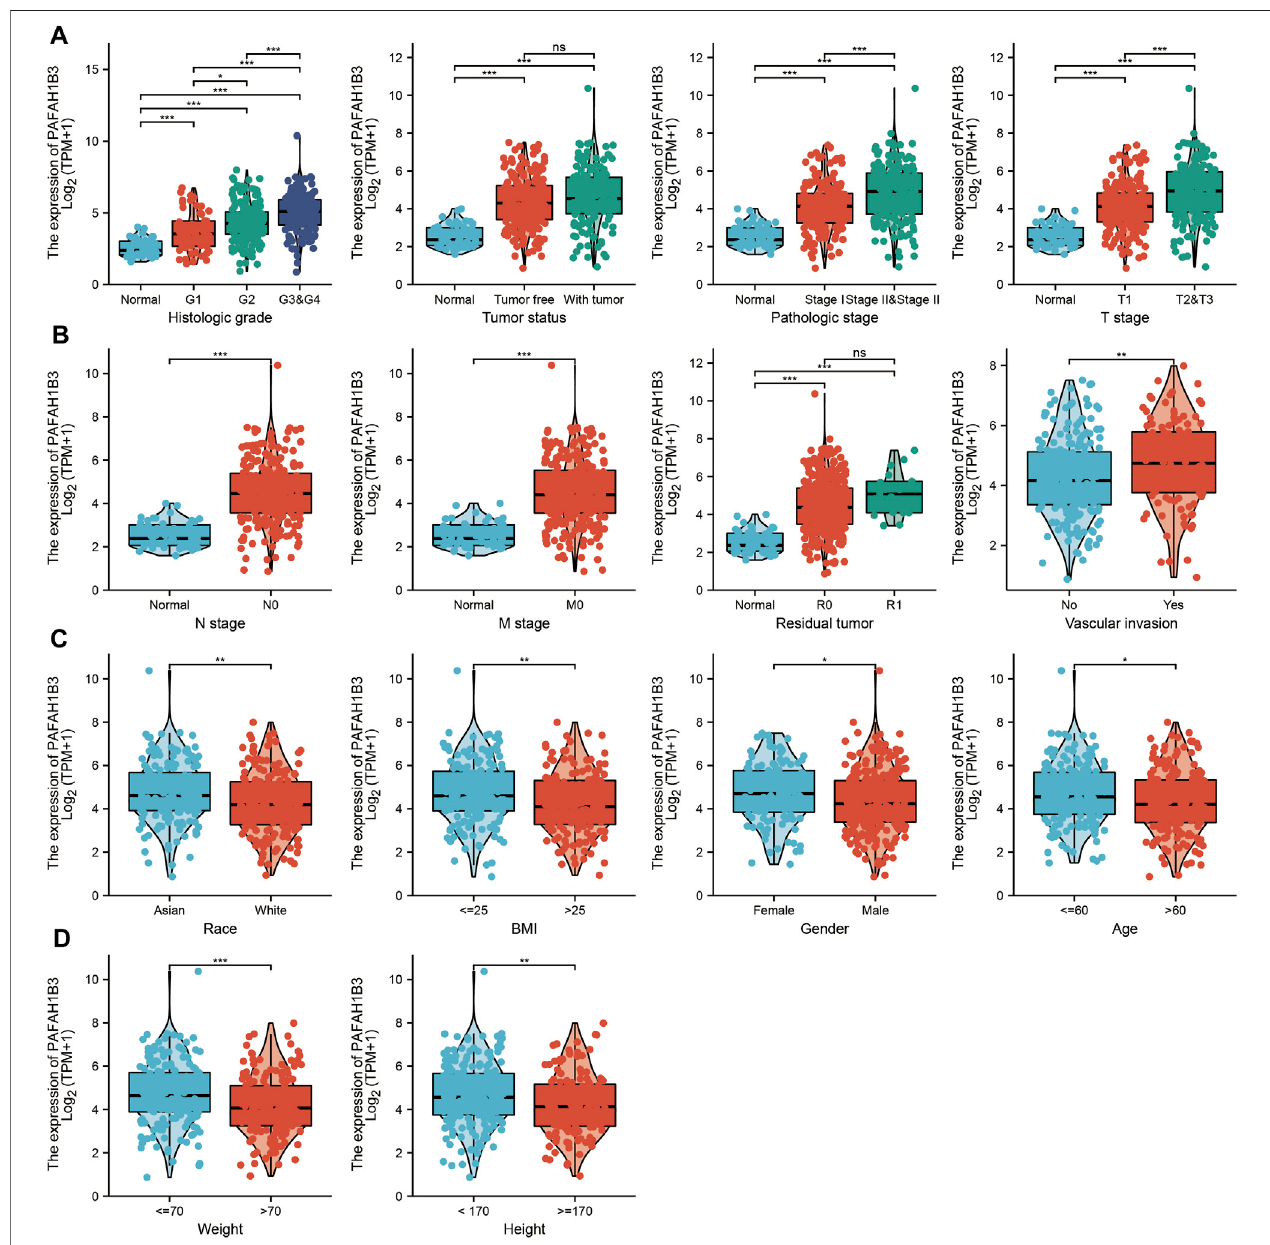
FIGURE 7 | PAFAH1B3 Is Correlated With Clinical Characteristics in LIHC. (A – D) The correlation between PAFAH1B3 expression and Clinical Characteristics in LIHC, including the histologic stage, Tumor status, pathologic stage, TNM stage, residual tumor, vascular invasion, race, BMI, Gender, age, weight, and height.